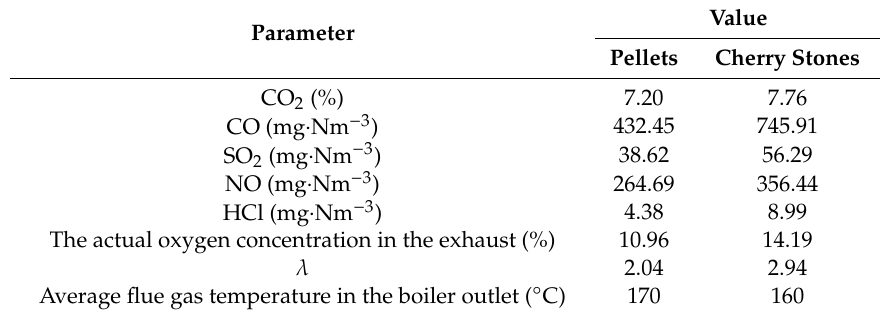
Table 2. Flue gas composition and conditions of combustion of cherry stones with 20% rye bran and cherry stones without any